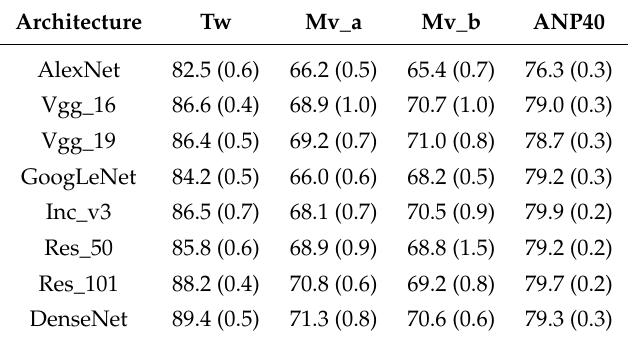
Table 5. Experimental results: Session #1, layer